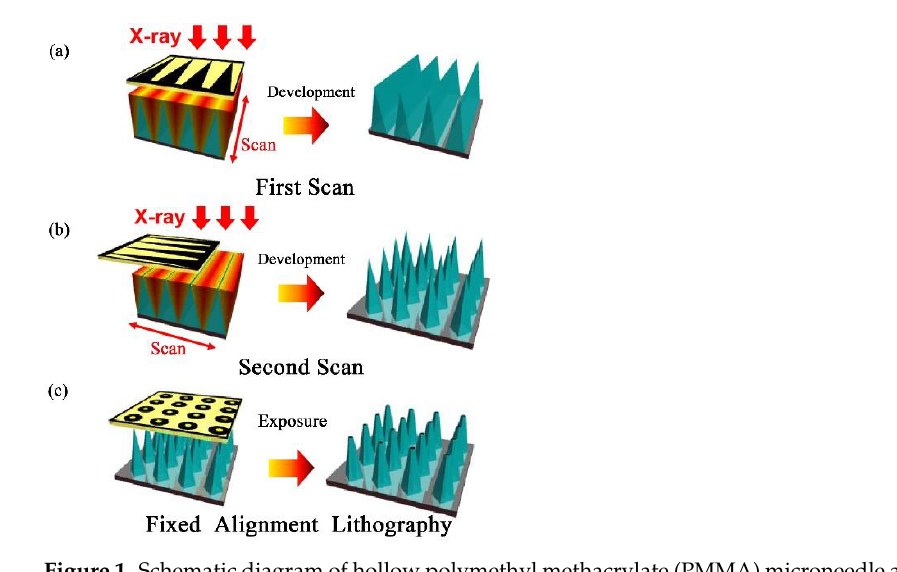
Figure 1. Schematic diagram of hollow polymethyl methacrylate (PMMA) microneedle arrays (MNA) prepared by Twice moving X-ray lithography process and fixed alignment X-ray exposure process. ( a ) First moving exposure. ( b ) Second moving exposure. ( c ) Fixed alignment lithography.